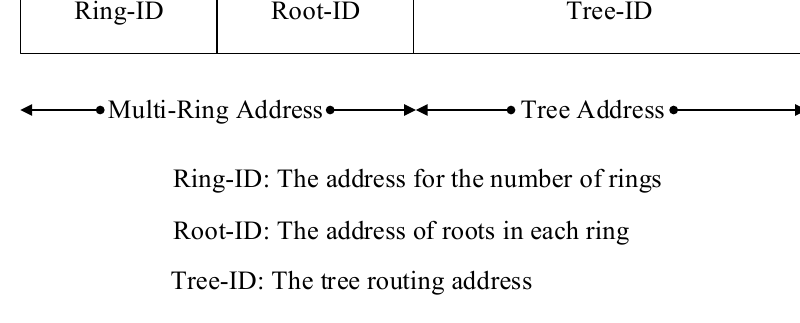
Figure 4. Multi-ring tree scatternet address field of a packet.